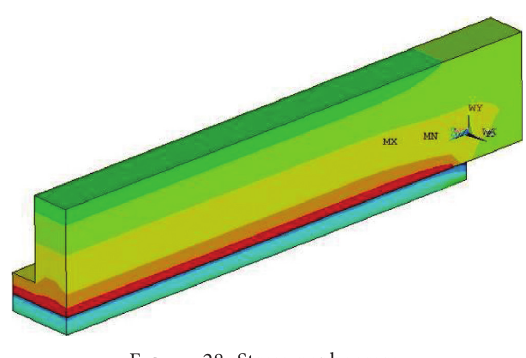
Figure 27: Time history plot.